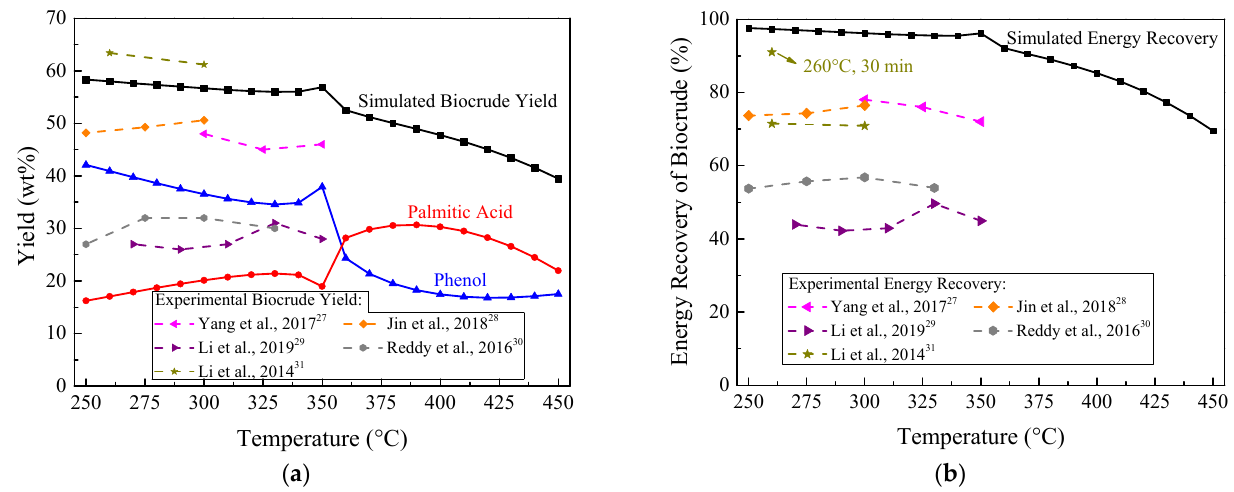
Figure 4. Effect of temperature on: ( a ) biocrude yield; ( b ) energy recovery at 20 MPa and with 80 wt% moisture content.